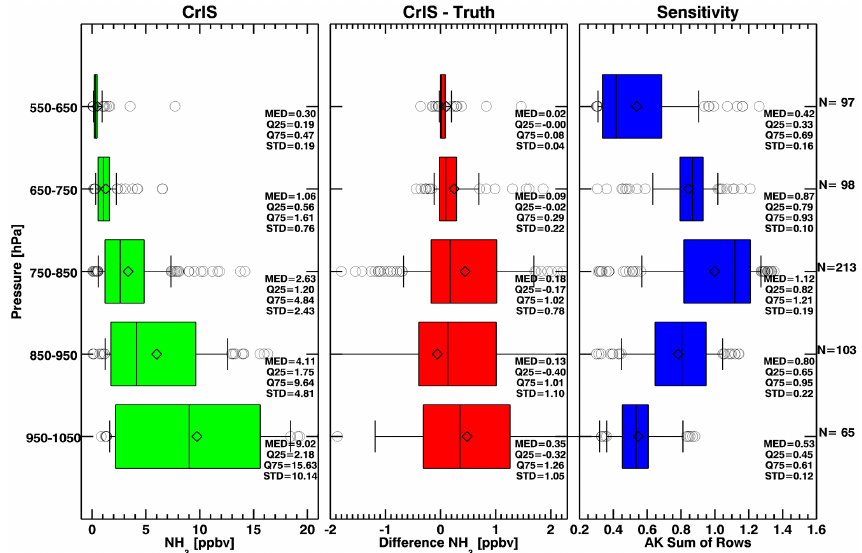
Figure 3. General characteristics for the simulated CrIS profile retrievals in Fig. 2 binned by pressure. The box edges are the 25th and 75th percentile, the line in the box is the median, the diamond is the mean, the whiskers are the 10th and 90th percentiles, and the circles are the outlier values outside the